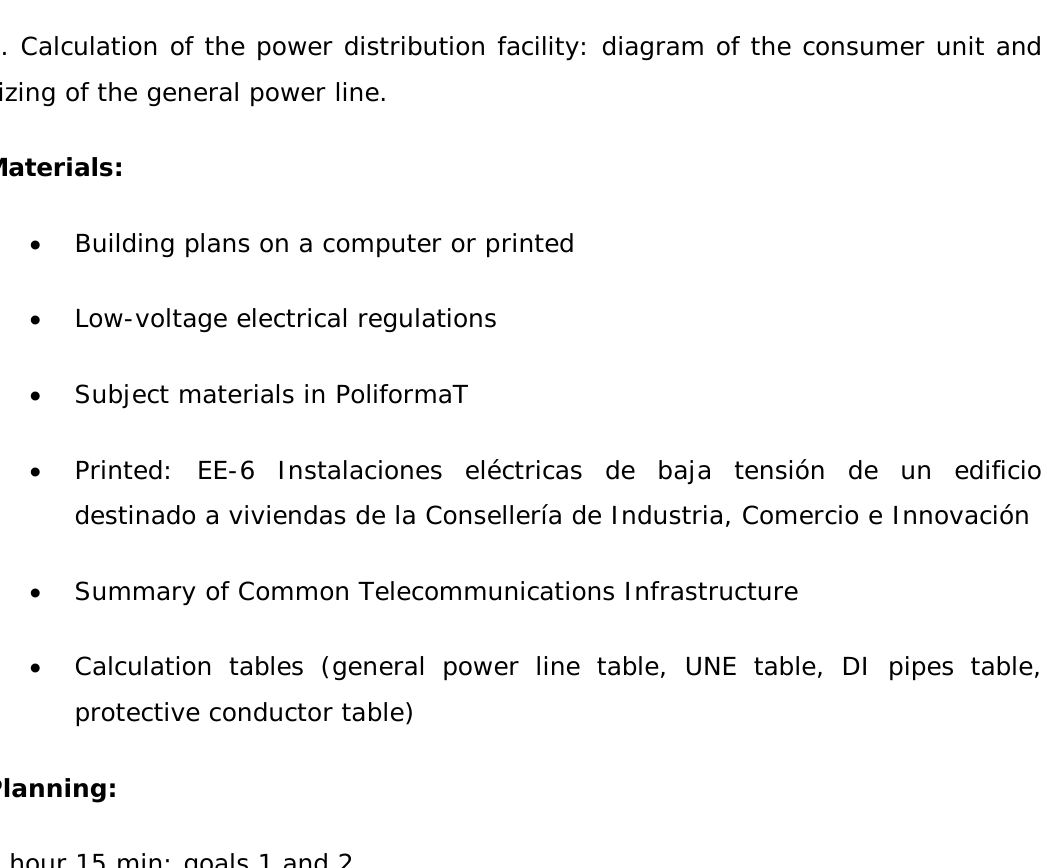
Calculation tables (general power line table, UNE table, DI pipes table, protective conductor